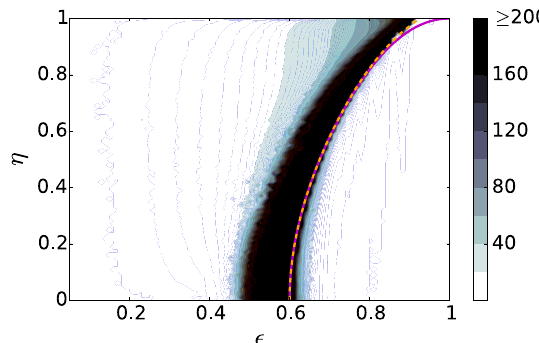
FIG. 4. The convergence time of belief propagation diverges as we approach the transition. This heat map shows the number of iterations it takes BP to converge to a fixed point, with the same parameters as in Fig. 3. As before, the dashed curve shows the detectability transition for T ¼ 40 , and the magenta curve shows the transition for T ¼ ∞